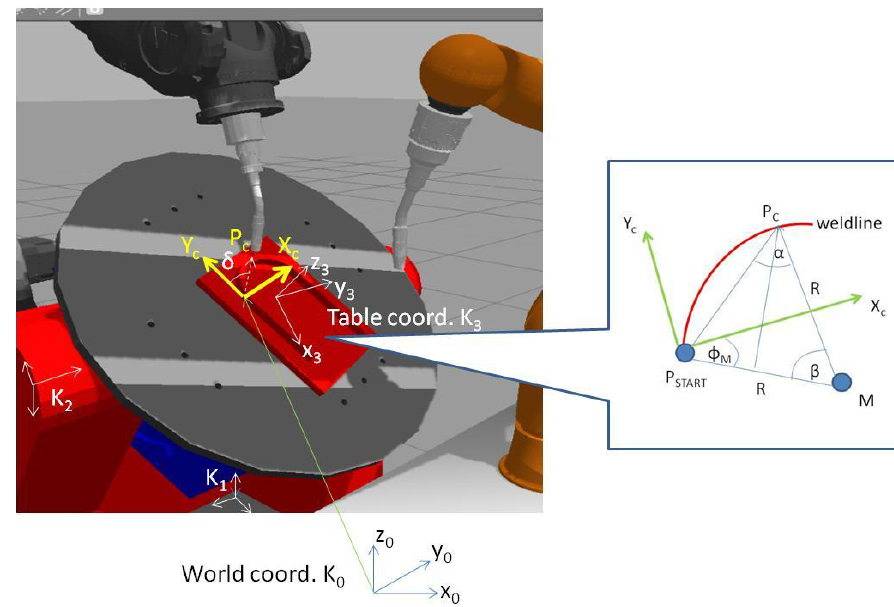
Figure 5. Geometrical conditions in planning of robot and turntable motion for circular welds in a gravity position.